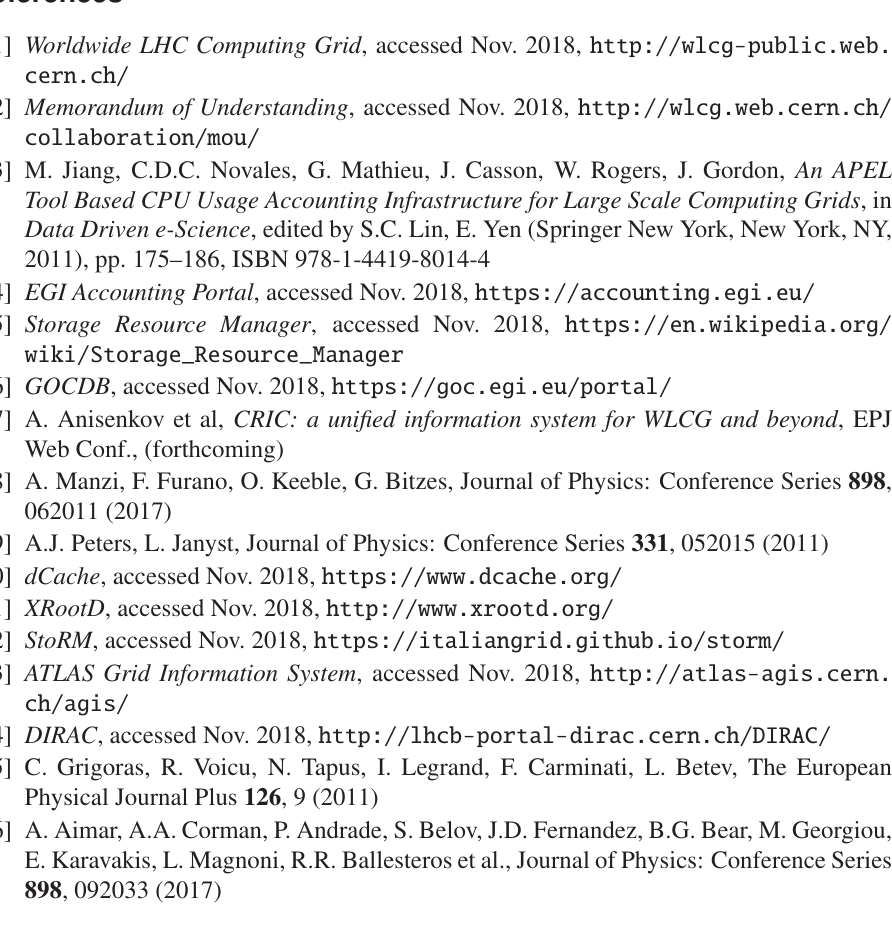
Figure 4. The tape-specific dashboard exposes additional metrics that are relevant to the tape